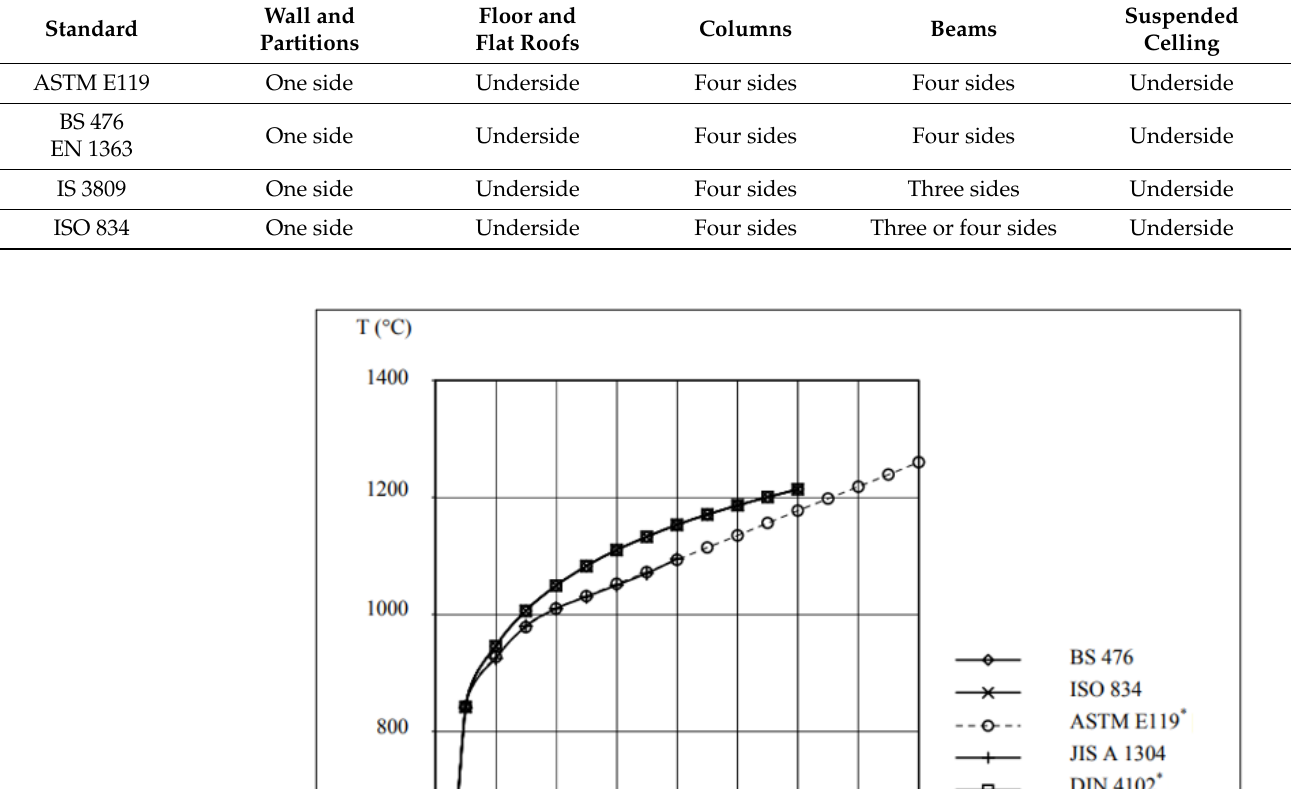
Table 7. Heating method of different test standards.